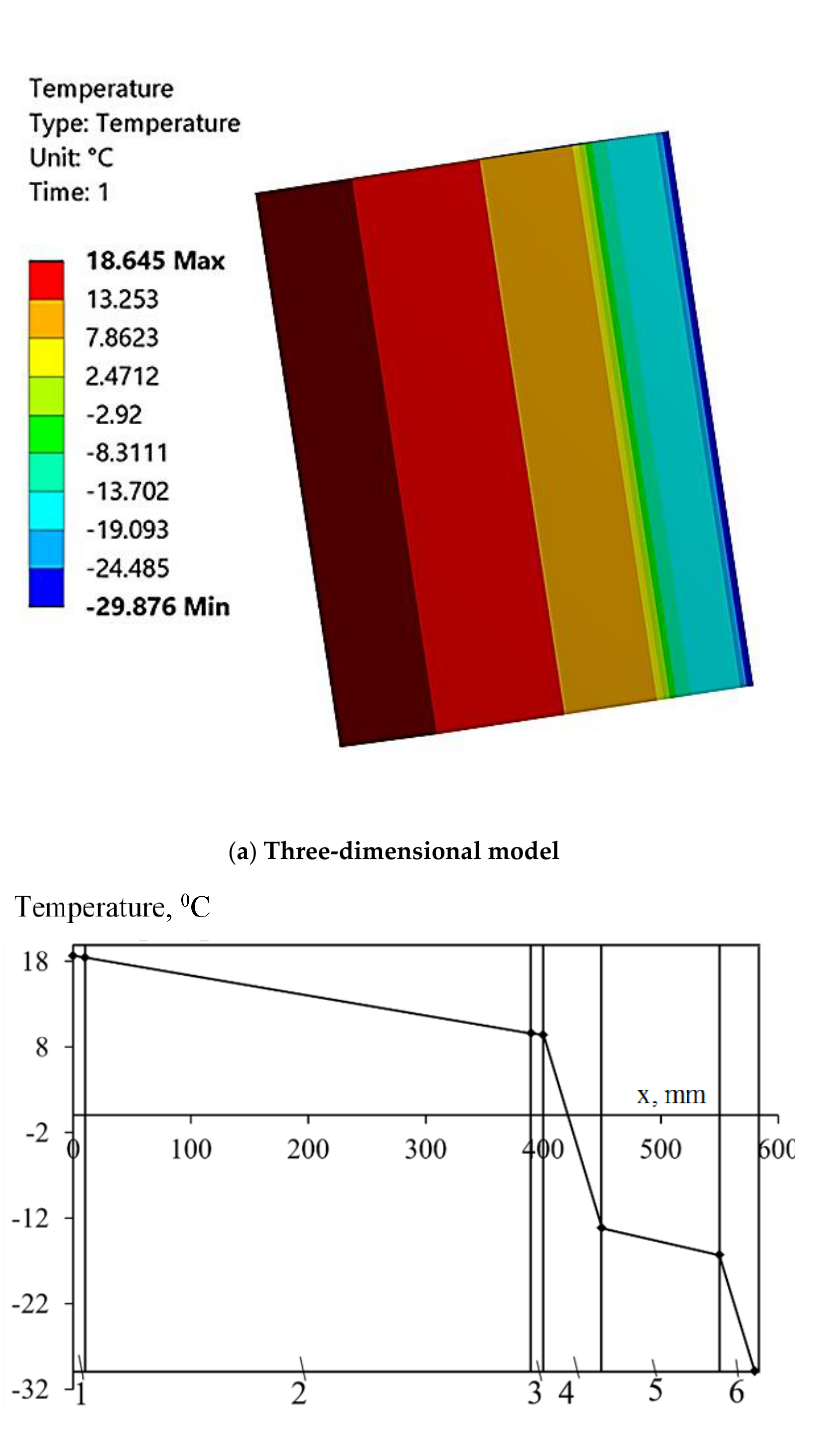
Figure 11. Temperature field in the enclosure at the absolute minimum ambient temperature: ( a ) — three-dimensional model; ( b ) — graph of temperature changes along the enclosure thickness: 1, 3 — cement-sand plaster; 2 — bearing layer from ceramic brick; 4 — insulant — extruded polystyrene foam; 5 — closed air gap.